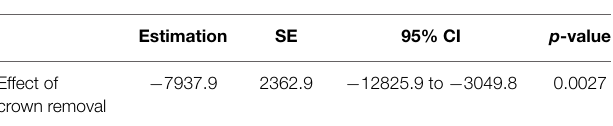
TABLE 3 | Crown presence had a strong positive effect (increase) in overall stiffness for all treatments when considered in aggregate . The overall effect of crown removal on stiffness for all treatments